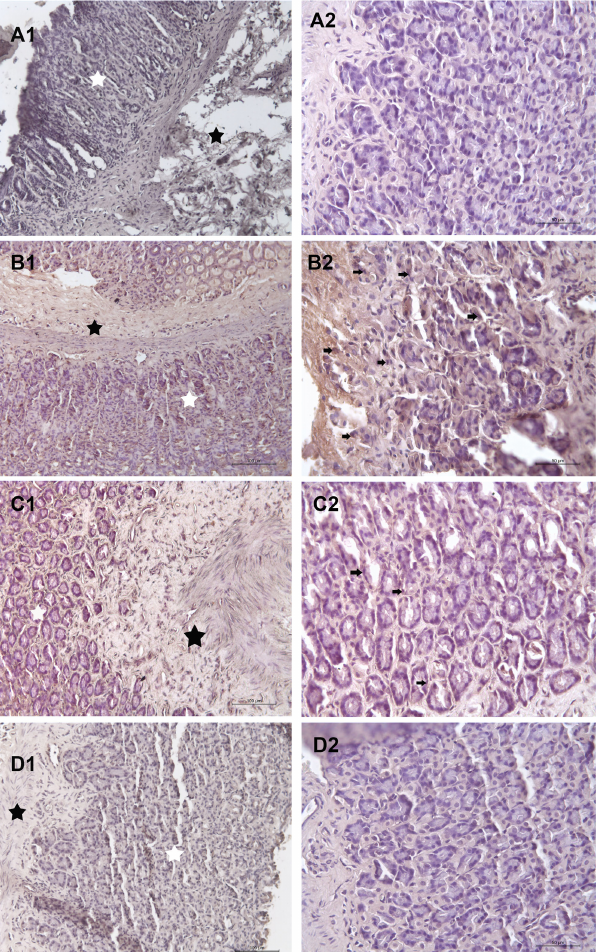
Figure 4. Immunohistochemical staining (TUNEL) images of the representative gastric samples from the experimental groups: Figure 5. Immunohistochemical staining (TUNEL) images of the ethanol control group (A1, A2), ethanol ulcer group (B1, B2), representative gastric samples from the experimental groups: indo MET-ethanol ulcer group (C1, C2), and RTN-ethanol ulcer group control group (A1, A2), indo ulcer group (B1, B2), MET-indo ulcer (D1, D2). Black arrows demonstrate the apoptotic cells in tunica group (C1, C2), and RTN-indo ulcer group (D1, D2). Black arrows submucosa (black asteriks) and tunica mucosa (white asteriks). demonstrate the apoptotic cells in tunica submucosa (black Scales and original magnification: 100 µm and 20 × (A1, B1, C1, D1) asterisks) and tunica mucosa (white asterisks). Scales and original and 50 µm and 40 × (A2, B2, C2, D2). magnification: 100 µm and 20 × (A1, B1, C1, D1) and 50 µm and 40 × (A2, B2, C2,